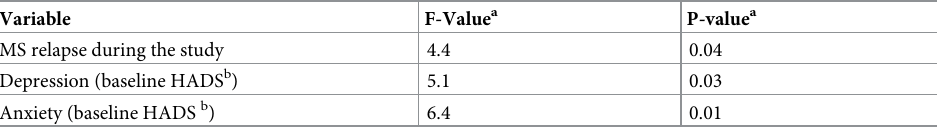
Table 5. Predictors of maximal change over time in e-diary derived bodily function patient reported outcomes.